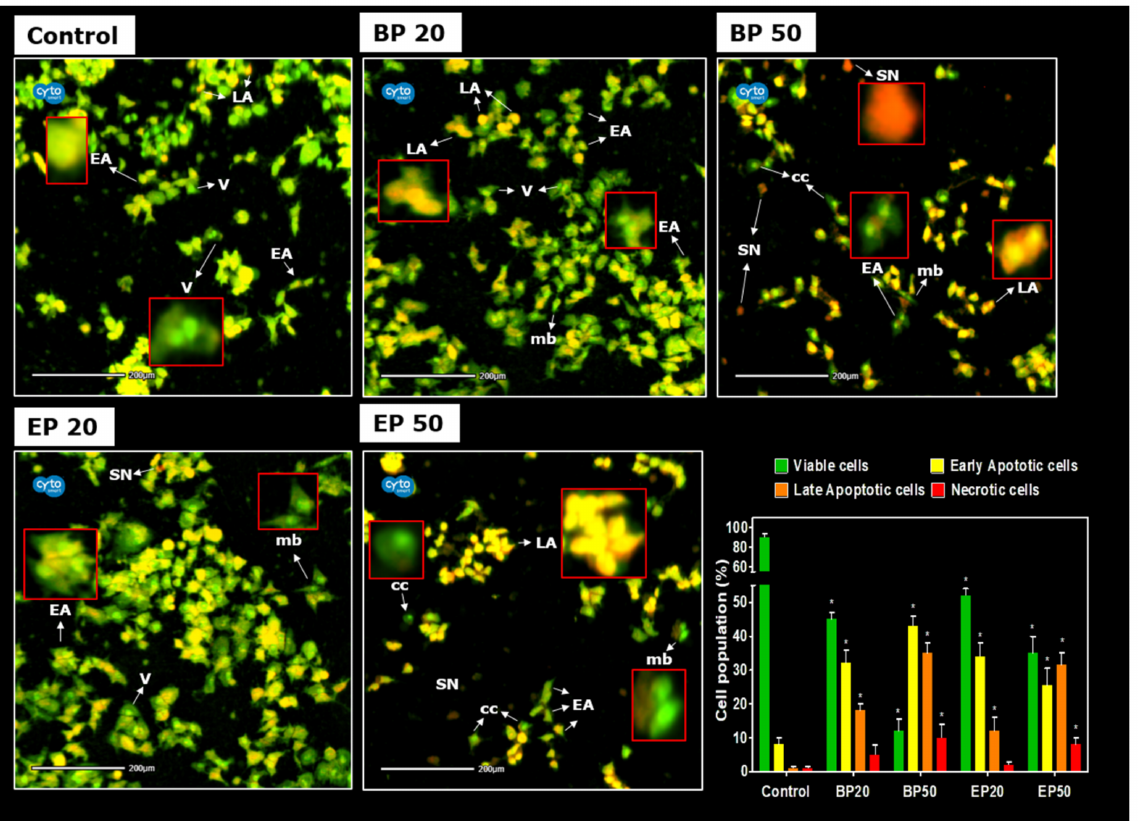
Figure 5. Fluorescent images of AO/PI dual-stained HEp2 cells after treatments with BP and EP at IC 20 and IC 50 concentrations for 48 h captured by CytoSMART®Lux3 FL fluorescence microscope. Green nucleus represents viable cells, early apoptotic cells show yellow color, and late apoptotic cells display orange color. Intense red color cells indicate the secondary necrotic condition. The bar graph represents the percentage of cell population in apoptotic phases. The results are expressed as mean ± SD of triplicate experiments. * p < 0.05 significance difference between the control and treatment. (V, viable cells; EA, early apoptosis; LA, late apoptosis; SN, secondary necrosis; mb, membrane blebbing; cc, chromatin condensation). Scale: 200 µ